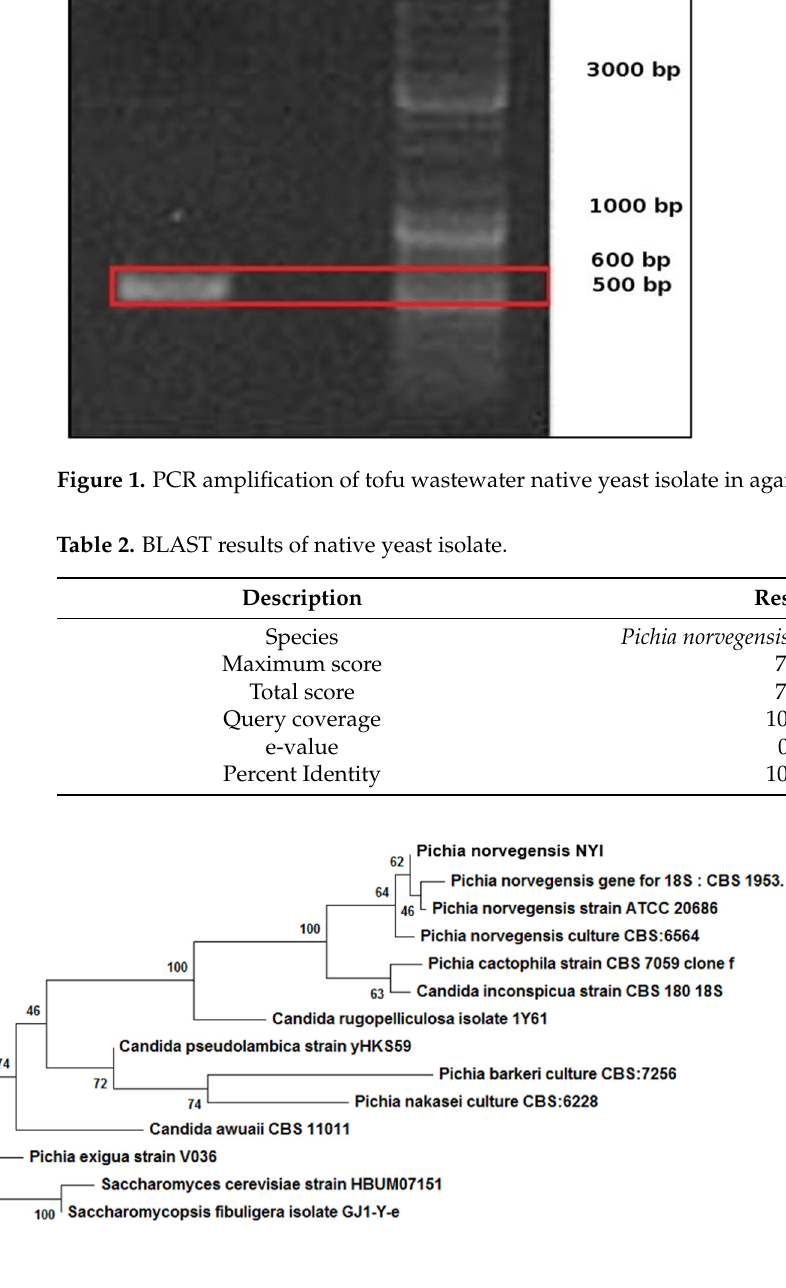
Figure 2. Phylogenetic tree of Pichia norvegensis NYI.